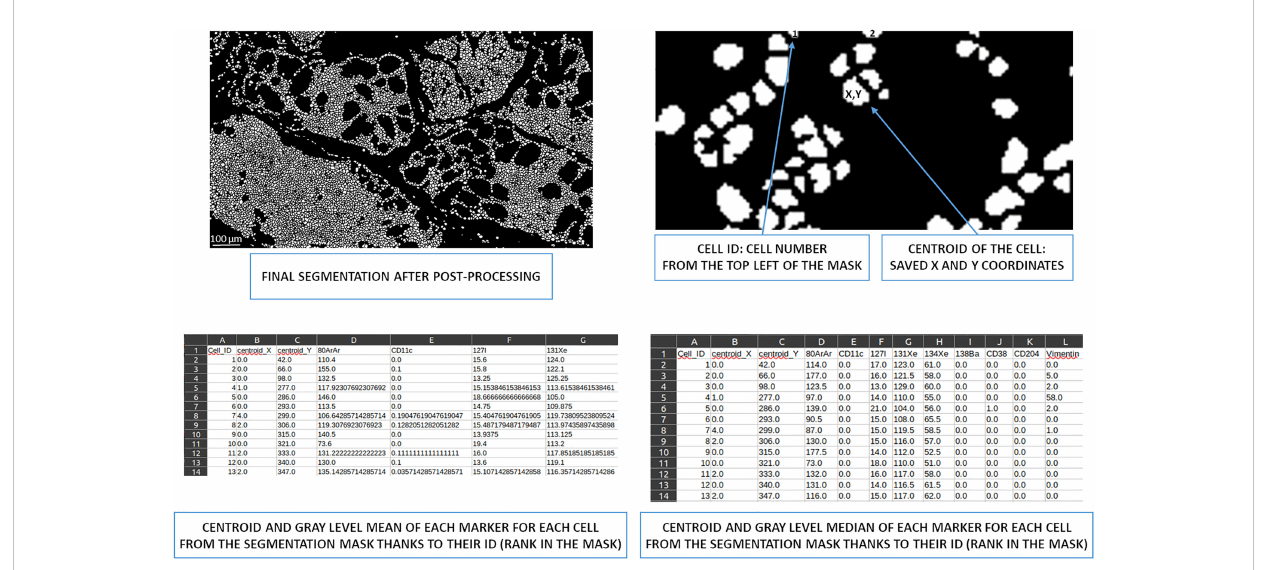
FIGURE 6 Overview of cell ID to obtain centroids and the mean/median of gray levels per marker. Based on the image from the post-processing segmentation, all cells were identi fi ed and had X and Y coordinates thanks to their centroid. This information is written in a CSV fi le. This fi le also contains the mean intensity of each marker for each cell. A second CSV fi le contains the median intensity of each marker for each cell. ID,